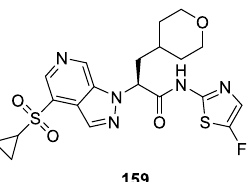
Figure 45. Chemical structure of 1,4-disubstituted-1 H -indazole derivative 159 .